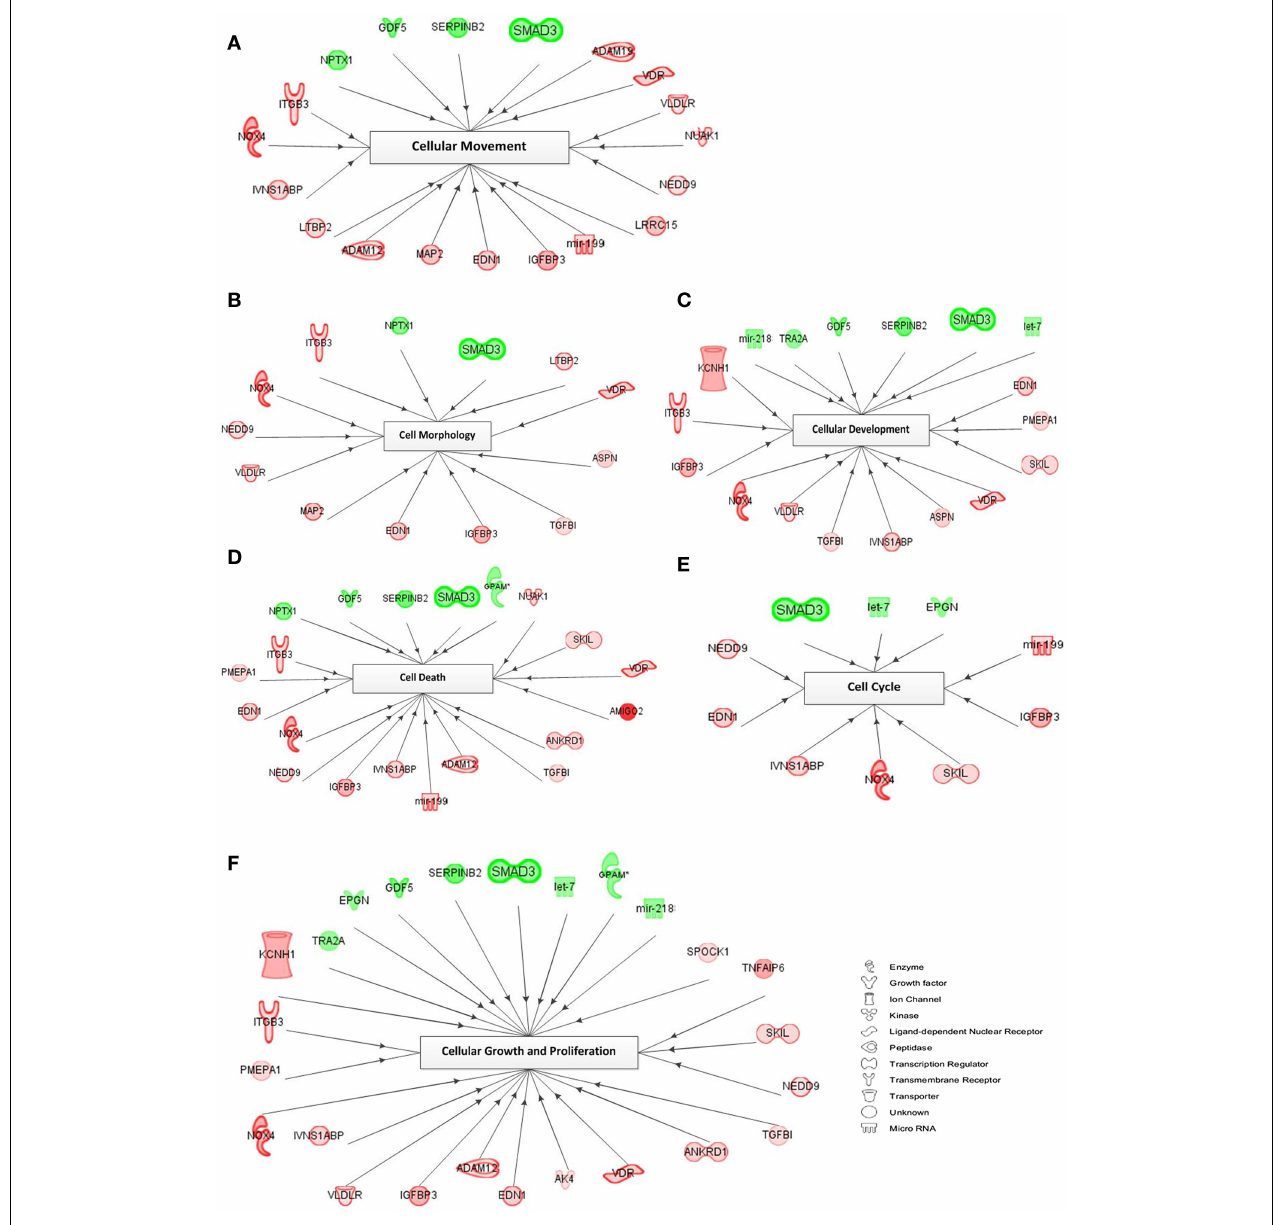
to construct a gene association map for predicting various cellular and molecular events operating within the palatal mesenchyme (A–F) . Red symbols specify upregulated expression of genes, whereas green symbols indicate downregulated genes.The color darkness represents the FC